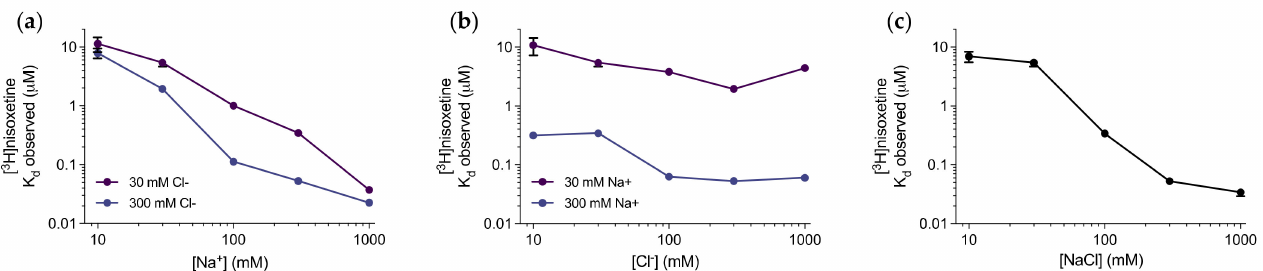
Figure 2. Influence of ions on the K d for [ 3 H]nisoxetine. ( a – c ) Log-log plots of fitted K d values under varied or constant Na + and Cl − ion concentrations, as indicated on the graphs. ( a ) Na + - dependent changes in K d for [ 3 H]nisoxetine in the high (300 mM, blue) or low (30 mM, purple) Cl − concentrations. ( b ) Cl − -dependent changes in K d for [ 3 H]nisoxetine in the high (300 mM, blue) or low (30 mM, purple) Na + concentrations. ( c ) NaCl-dependent changes in K d for [ 3 H]nisoxetine. Each data point is graphed with the standard deviation for the fitted value, derived from [ 3 H]nisoxetine saturation shown in Supplementary Figure S1. The data points are representative of triplicates from a singular dDAT purification, all plotted as mean ± SD.